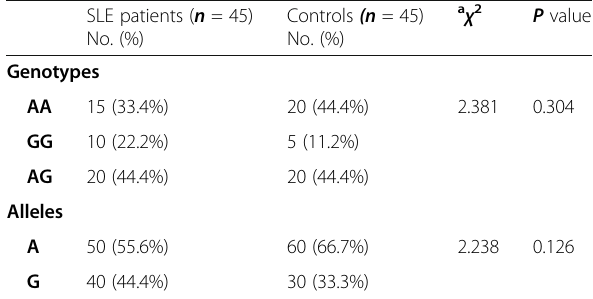
Table 1 Genotype and allele frequency of XRCC1 Arg 399 Gln polymorphism among the studied participants ( n = 90) SLE patients ( n = 45) Controls (n = 45) No. (%) No.